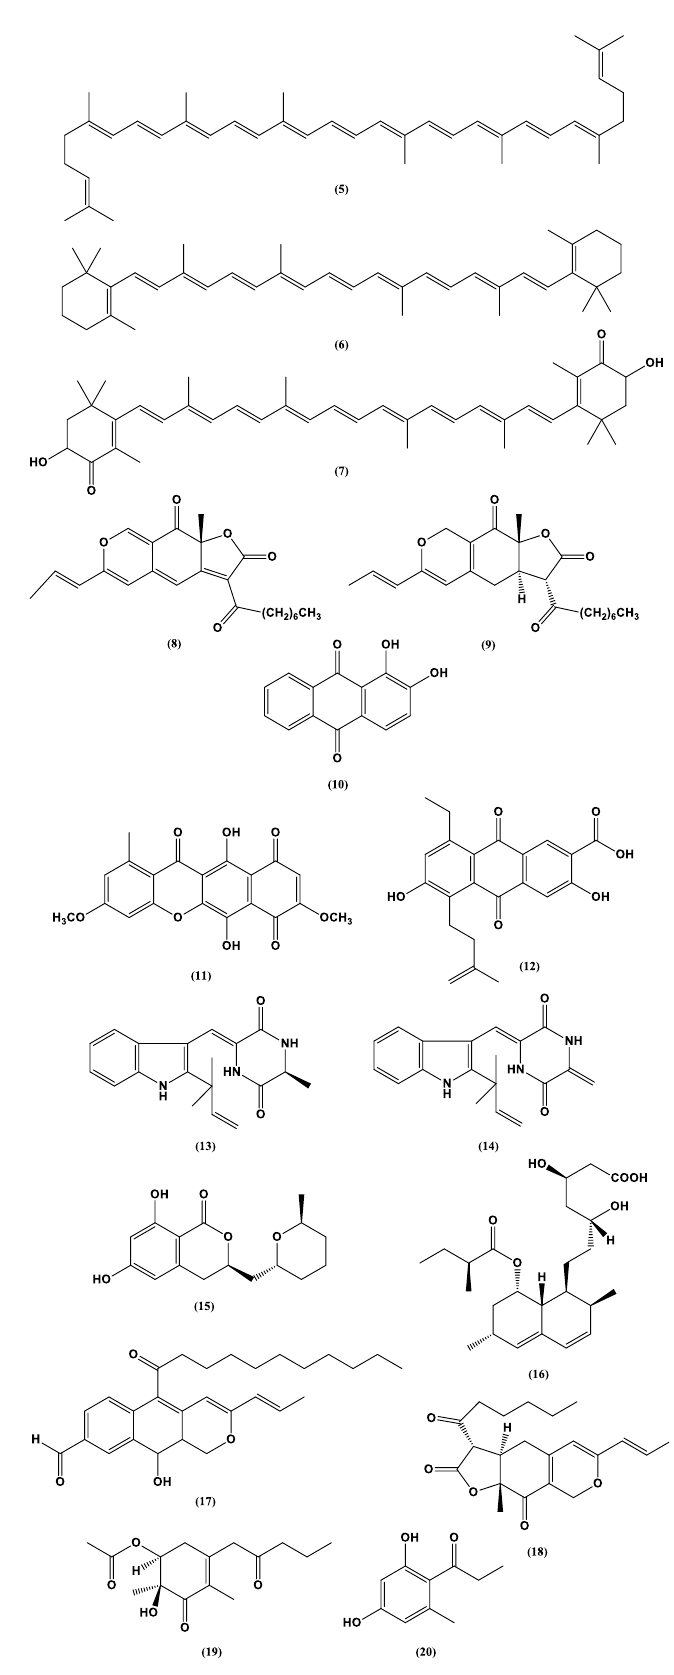
Figure 2. Chemical structures of some colored fungal secondary metabolites (5–20) .